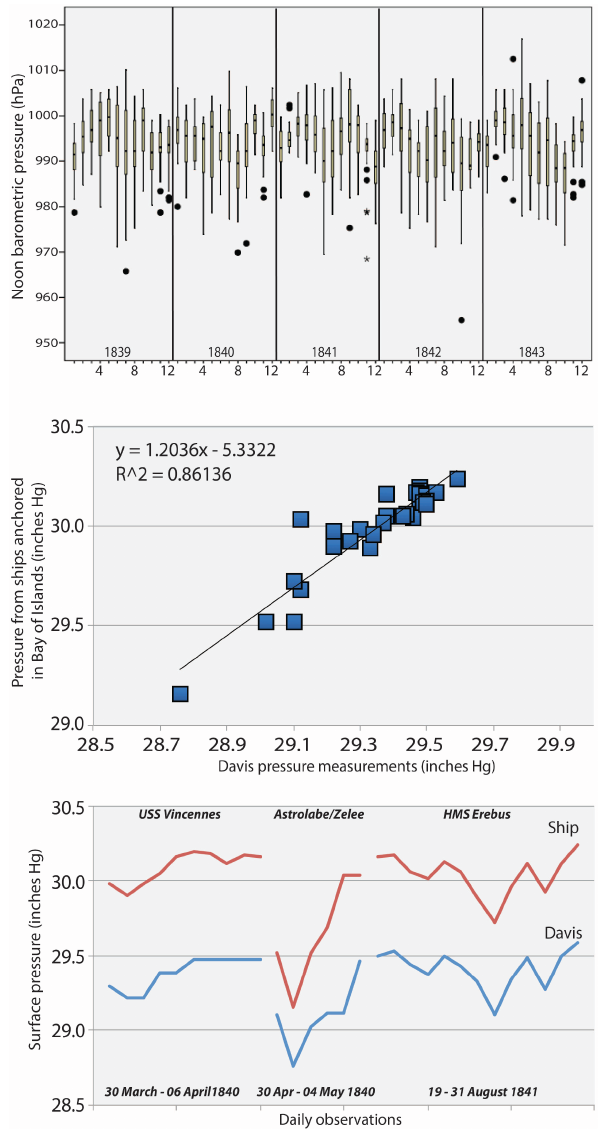
Figure 3. Top: monthly pressure observations from the Reverend Richard Davis (RRD) meteorological diary for 1839–1843. Num- ber on x axis denotes month of each year. Circles represent values that are 1.5 to 3 times the interquartile range away from the mid- dle 50% of all of the data, while stars represent extremes that are more than 3 times the interquartile range away. Middle: compari- son of pressure observation in inches mercury from RRD relative to ship data in the Bay of Islands for the same day. Bottom: RRD pressure observation vs. expedition measurements (leader noted in parentheses) from USS Vincennes (Wilkes), the corvettes Astrolabe and Zelee (d’Urville) and the HMS Erebus (Ross). There are 29 pairs of daily observations and so the x axis simply shows the com- parisons of Davis’ record to the three ships in a sequence with the specific intervals